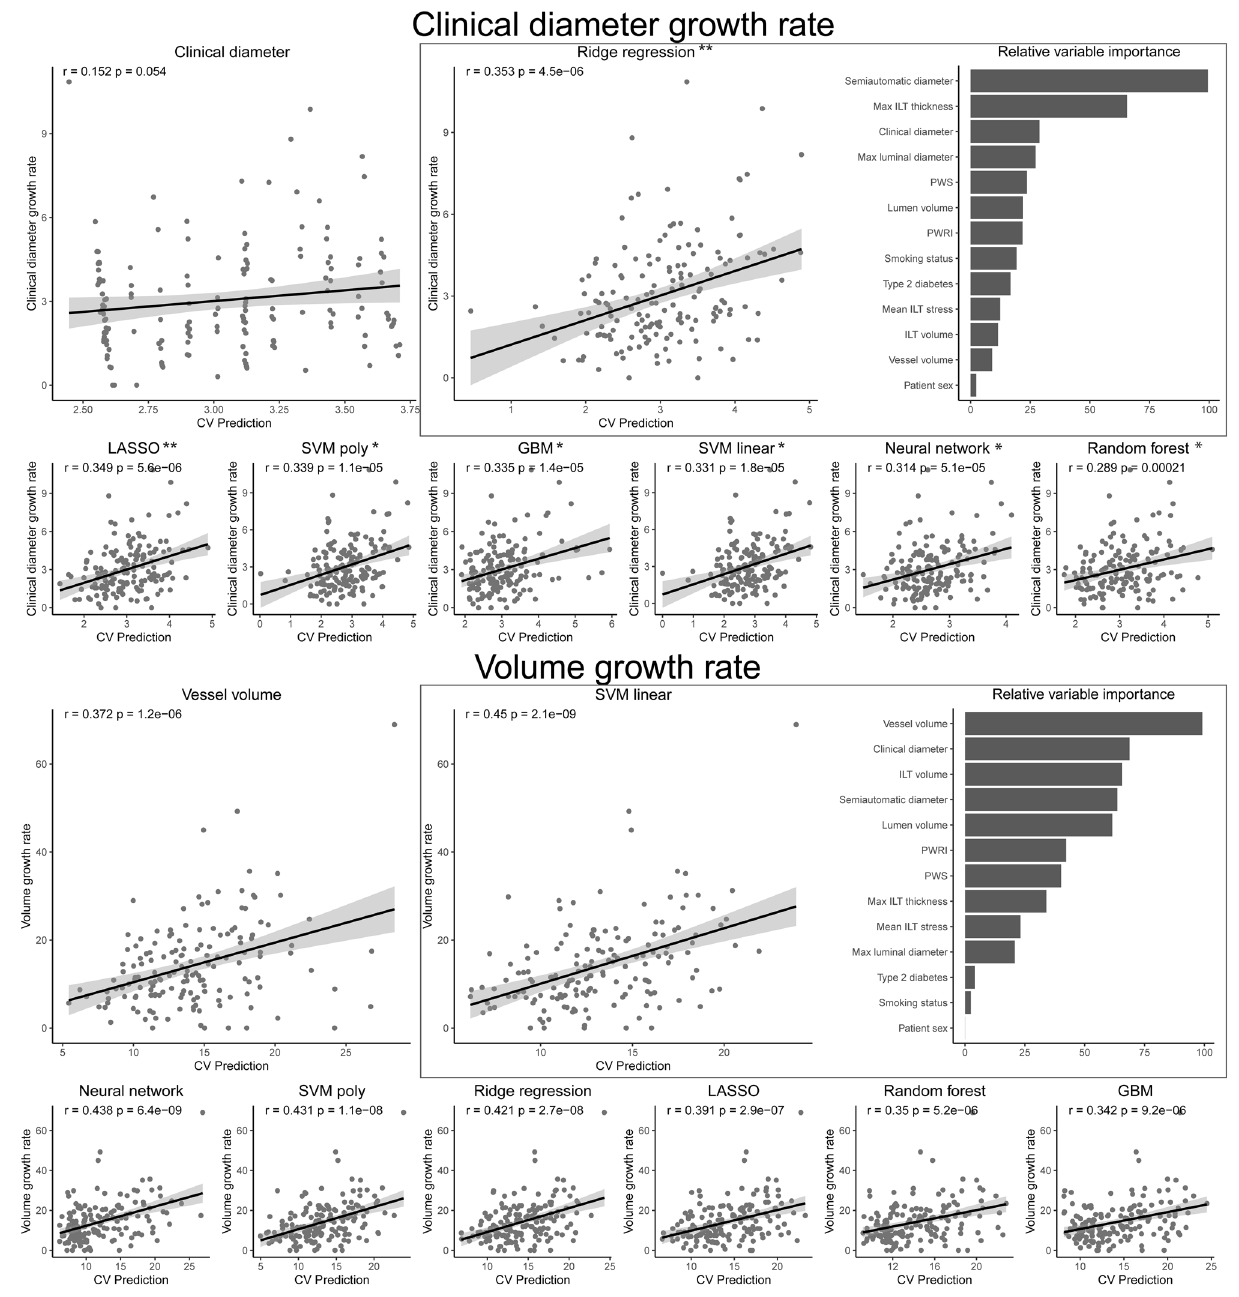
Figure 3. Prediction of aneurysm growth rate. Pearson correlation tests between the observed growth rates of clinical diameter or vessel volume and the cross-validated prediction. Linear regression of clinical diameter or vessel volume served as references. Models with significantly stronger correlation coefficients between prediction and observation, compared with the reference, were marked with stars. Variable importance is shown for the best models. Abbreviations ; CV: cross-validated. GBM: gradient boosting machines, ILT: intraluminal thrombus, LASSO: least absolute shrinkage and selection operator, PWRI: peak wall rupture index, PWS: peak wall stress, SVM: support vector machine with linear or radial basis function kernel. Notations: *: p < 0.05, **: p <